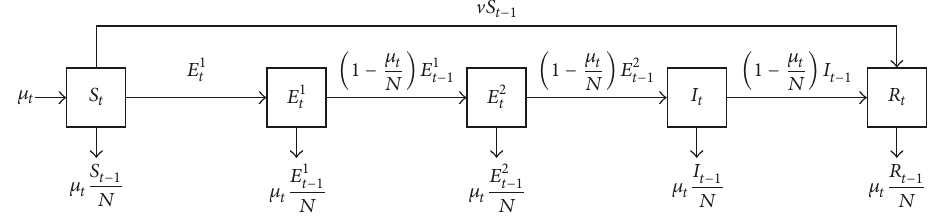
Figure 1: Flowchart of the proposed chickenpox model. Boxes represent compartments, horizontal arrows represent transitions between compartments, and downward arrows represent people leaving the